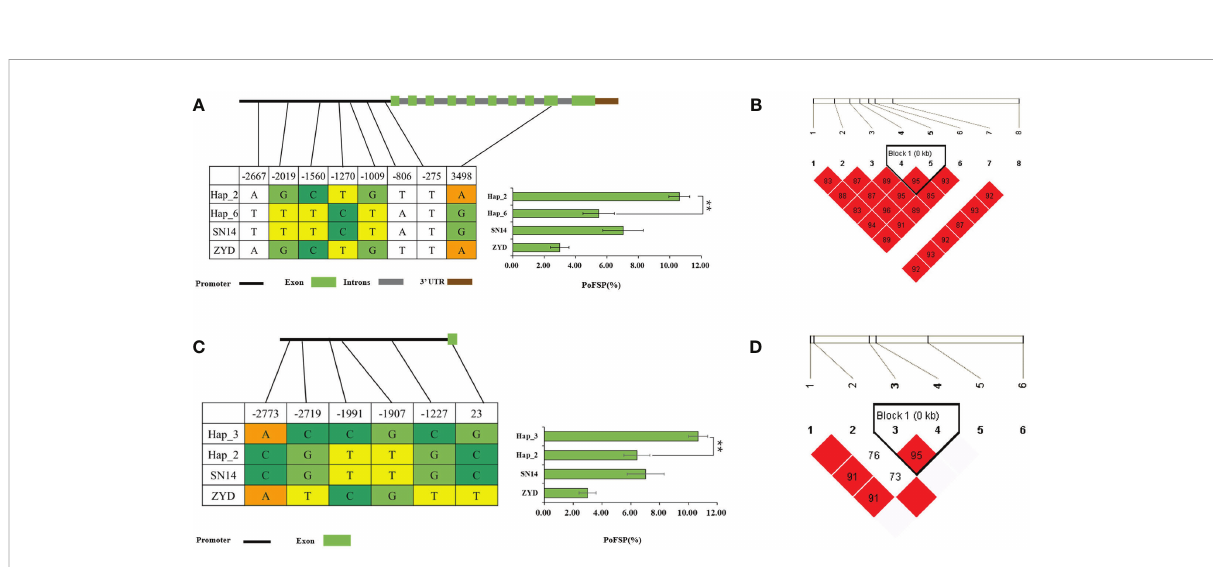
FIGURE 8 Haplotype analysis results of Glyma.13G126000 and Glyma.13G126100 . (A) : Correlation analysis of the major haplotype phenotype in Glyma.13G126000. (B) : LD analysis of SNPs among major haplotypes of Glyma.13G126000 . (C) : Correlation analysis of the major haplotype phenotype in Glyma.13G126100. (D) : LD analysis of SNPs among major haplotypes of Glyma.13G126100. a,c : “ ** ” indicates a signi fi cant difference at the 0.01 level.